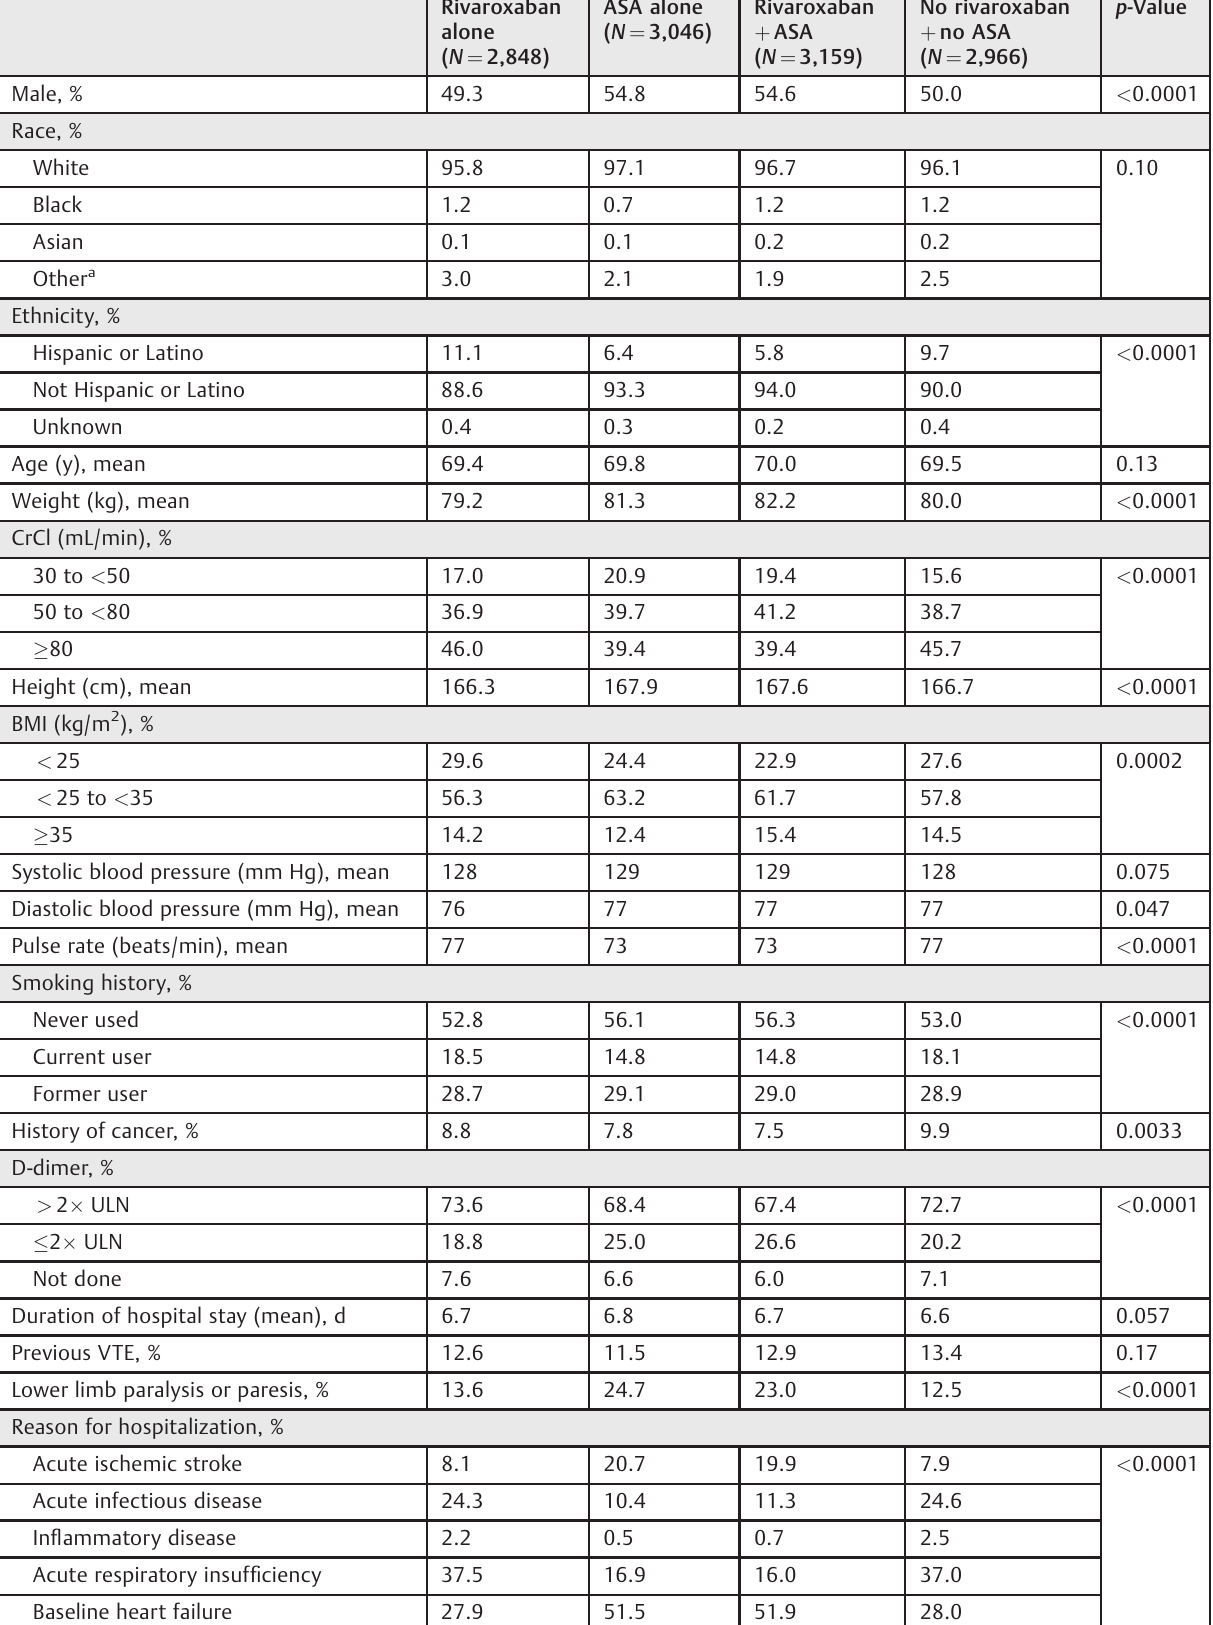
Table 1 Demographics and baseline characteristics in MARINER by treatment group (ITT population) Rivaroxaban